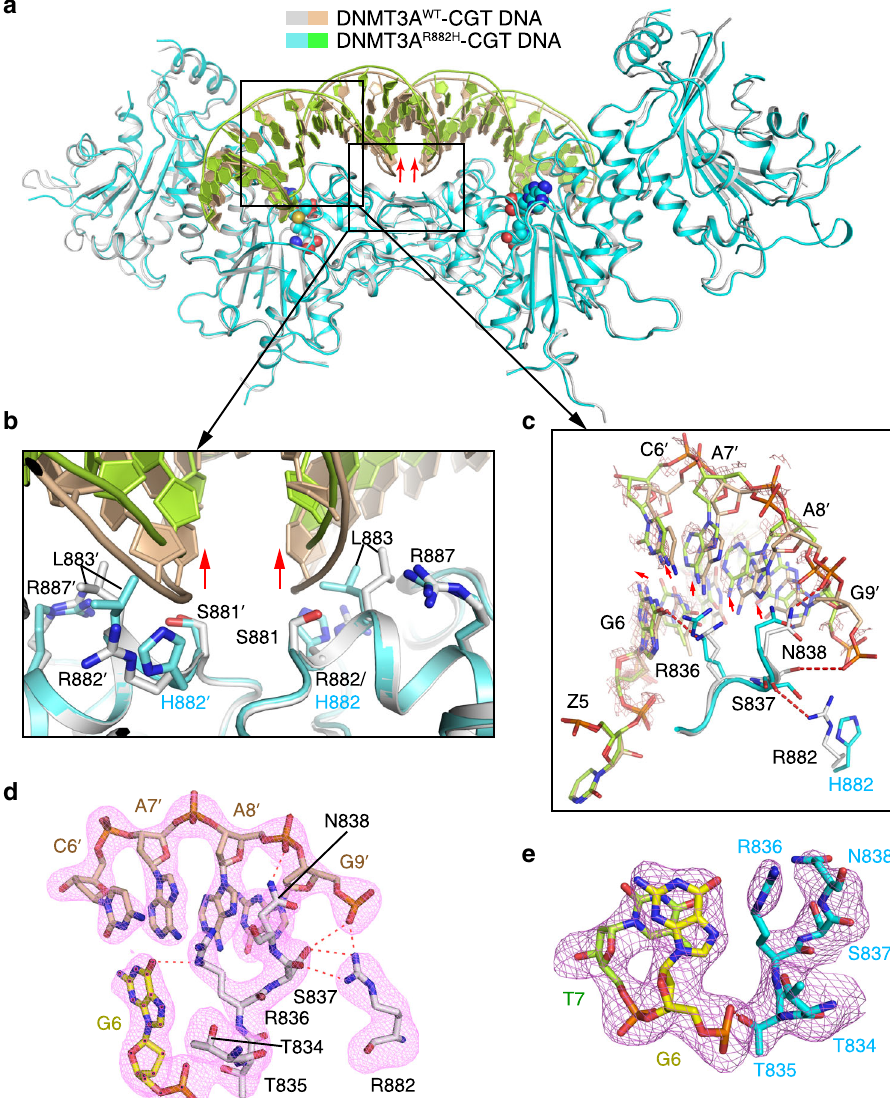
Fig. 4 Structural comparison of the DNMT3A WT – CGT and DNMT3A R882H – CGT complexes. a Structural superposition of the DNMT3A WT – CGT (PDB 5YX2) and DNMT3A R882H – CGT complexes. b Close-up view of protein – DNA interactions on the RD interface of the DNMT3A WT – CGT and DNMT3A R882H – CGT complexes. c Close-up view of the TRD loop and its interactions with CpG guanine (G6) and R882 in the DNMT3A WT – CGT and DNMT3A R882H – CGT complexes in expanded view. The hydrogen-bonding interactions are indicated by dashed lines. The conformational shifts of the DNA between the two complexes are validated by the 1.0 sigma Fo – Fo difference map (salmon) between the two complexes and indicated by arrows. d, e Close- up view of the interactions between the TRD loop and DNA in the DNMT3A WT – CGT (PDB 5YX2) ( d ) and DNMT3A R882H – CGT ( e ) complexes. The Fo – Fc omit map (violet) for the corresponding regions were contoured at 2.0 sigma